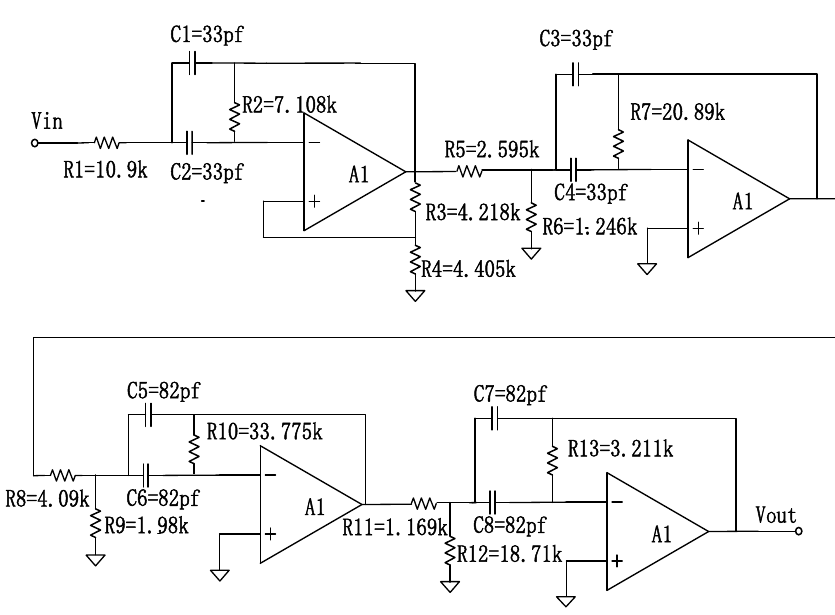
Figure 8. Schematic of the multi-chip module.